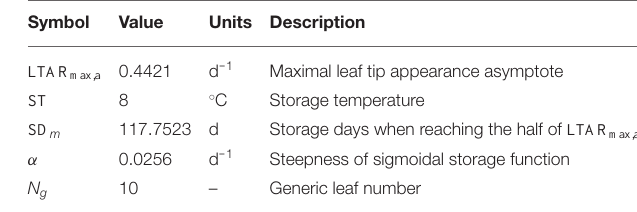
TABLE 1 | Parameters for dynamic